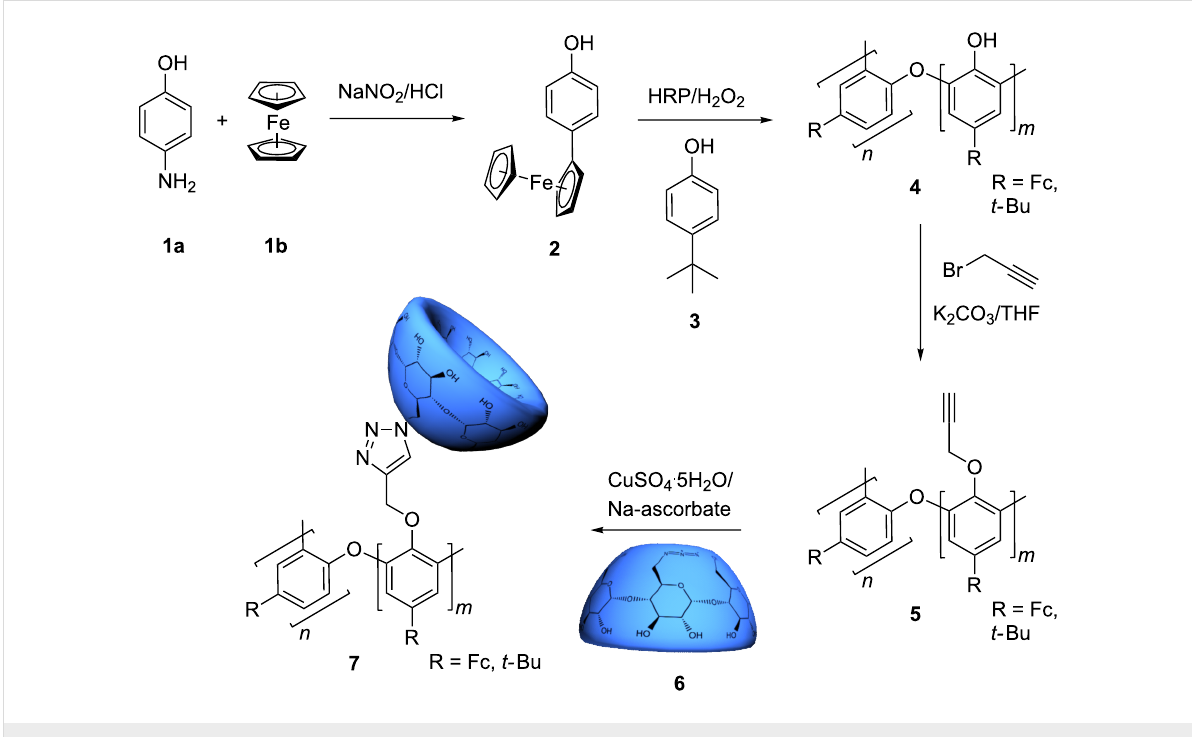
Scheme 1: Synthetic pathway to the desired polymer 7